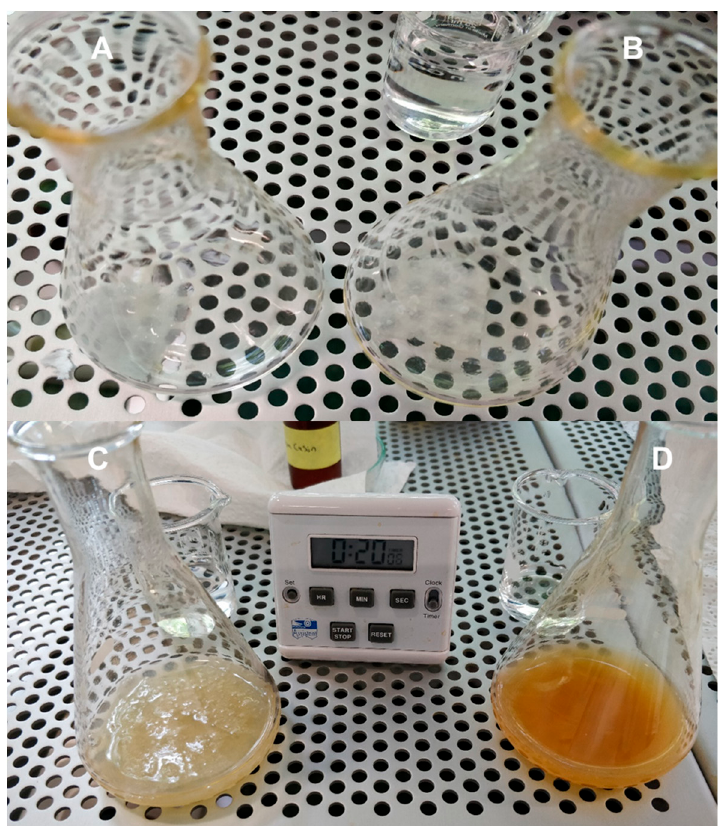
Figure 4. Differences between a type I Fenton reaction and a type II Fenton reaction that failed to initialize boiling when digesting a piece of tissue paper. ( A ), ( C ): type II before and after reaction. ( B ), ( D ): type I before and after